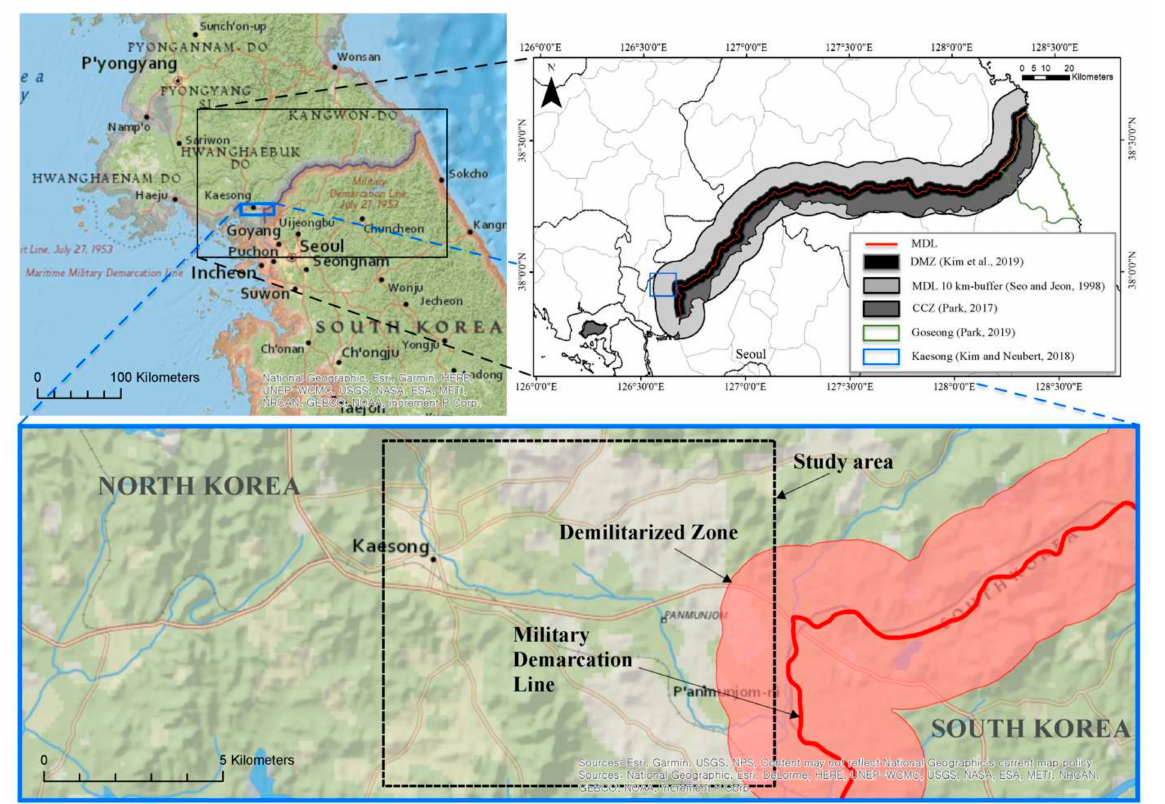
Figure 1. Geographical location of multiple study areas from the existing literature regarding the DMZ (upper-right) and our study area: the location of Kaesong and the adjacent DMZ area (bottom). The study area (black-dashed rectangle) is situated on the western side of the peninsula. Both the MDL and DMZ were determined by the Armistice Agreement in 1953 and digitized here based on this pact [22]. Notably, locational error exists in the background map provided by ArcGIS, as Panmunjom is incorrectly mapped in the middle of the river stream within the Kaesong region. In reality, Panmunjom is situated to the east, outside the present study area, in the middle of the MDL along a road connecting South and North